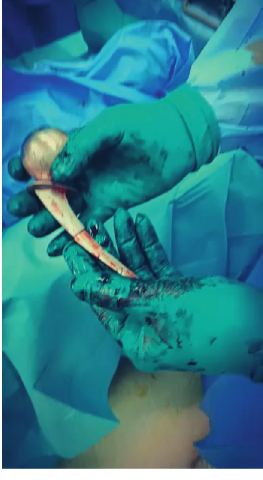
Figure 2: Intraoperative photos of window technique for stem removal. (a) A rectangular bone window done by saw at the lateral surface of proximal femur. (b) Elevation of the bone window to reveal the retained part of the stem. (c) Pushing the stem by an osteotome and hammer. (d) Delivery of the stem from the upper part of the femur. (e) Two parts of the Thompson prosthesis after removal.